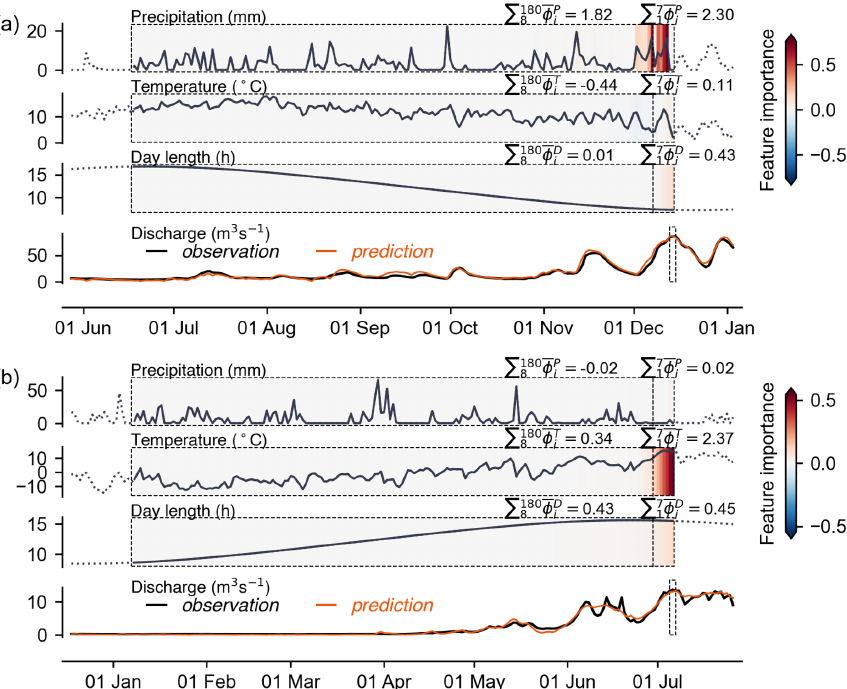
Figure 4. Additional examples to the case shown in Fig. 2, which illustrate the importance pattern of temperature, precipitation, and day length in predicting two discharge peaks from other catchments. (a) Recent precipitation contributes most to the discharge peak. (b) Recent temperature contributes most strongly to the discharge